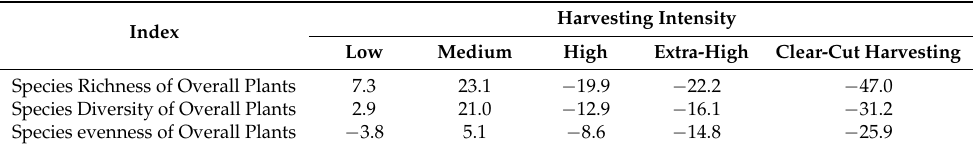
Table 7. Percentage changes in species diversity indices of overall plants due to different harvesting intensities relative to